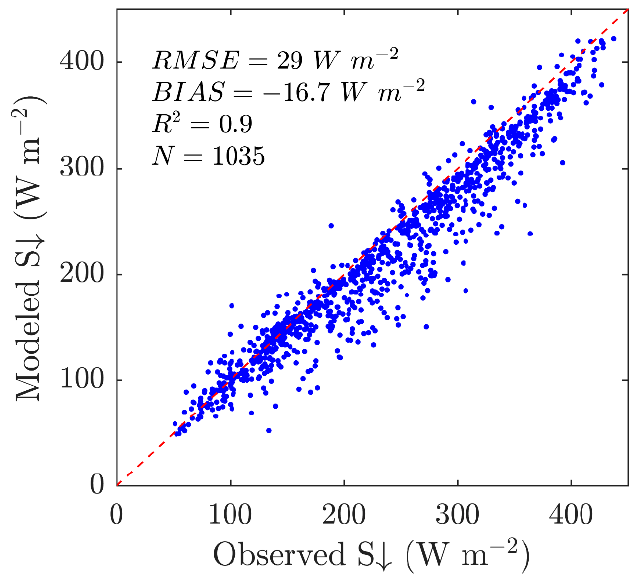
Figure 3. Observed and modeled incoming shortwave radiation (S ↓ ) at 5040 m AWS.